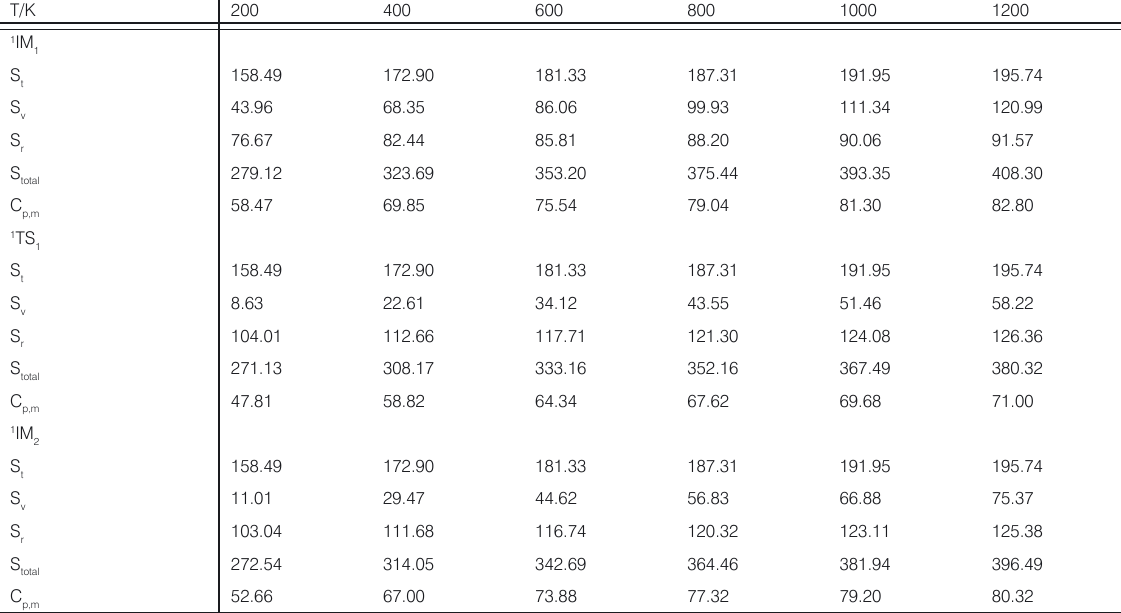
Table 1. The thermodynamic data for 1 IM J mol -1 K, J mol -1 K, respectively).